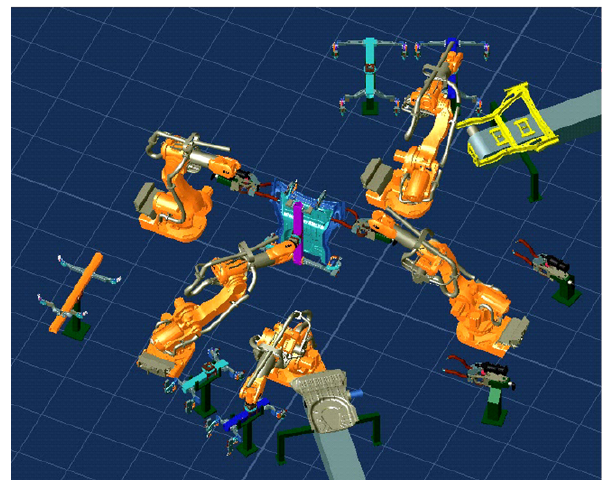
Figure 7: In complex robot installations, for example in the case of collaborating robots as in this figure, it is necessary to make use of accurate off-line programming software using the same robot control software as in the installation.